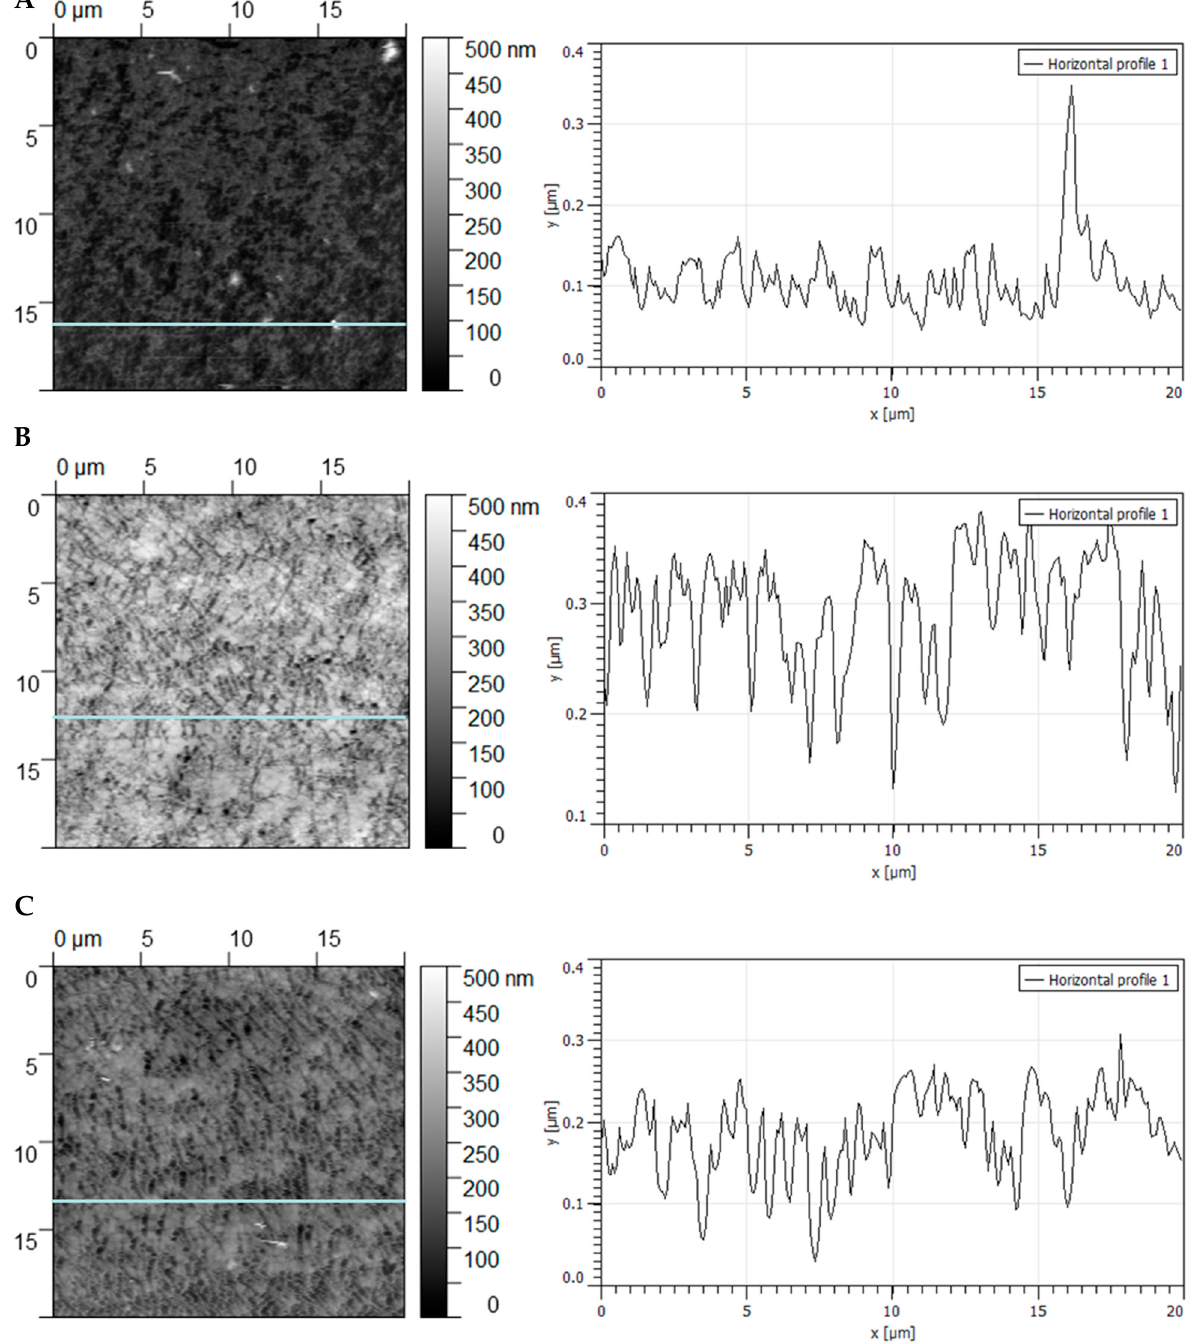
Figure 8. AFM images and surface profiles of silicon samples obtained: ( A )—before plasma treatment, ( B )—after plasma treatment, ( C )—the same sample as in B stored for four weeks under ambient